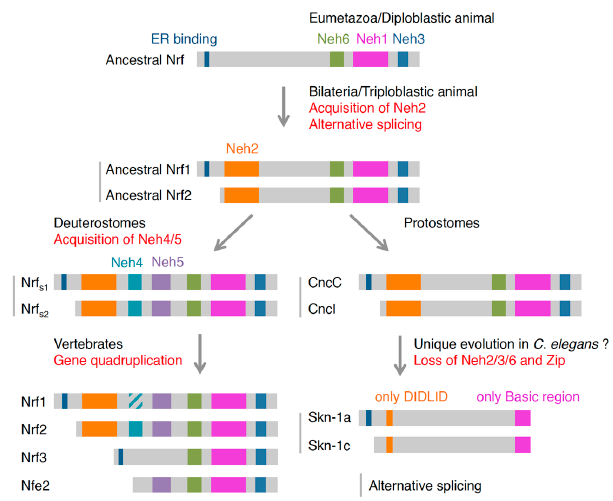
Figure 4. The evolution of Nrf/Cnc transcription factors deduced from amino acid sequences. Gray bars and subscripts (s1 and s2) in Deuterostomes Nrf denote products of alternative splicing. Taken together, these findings suggest that, at the latest, the mechanism of alternative splicing and generation of varied proteins from a single Nrf locus was already present at the appearance of triploblastic animals. In vertebrates, at gene quadruplication, varied proteins are assigned to each replicated locus. For the Nrf2 locus, a transcription factor regulated by a Keap1-dependent and ER- independent mechanism is assigned.